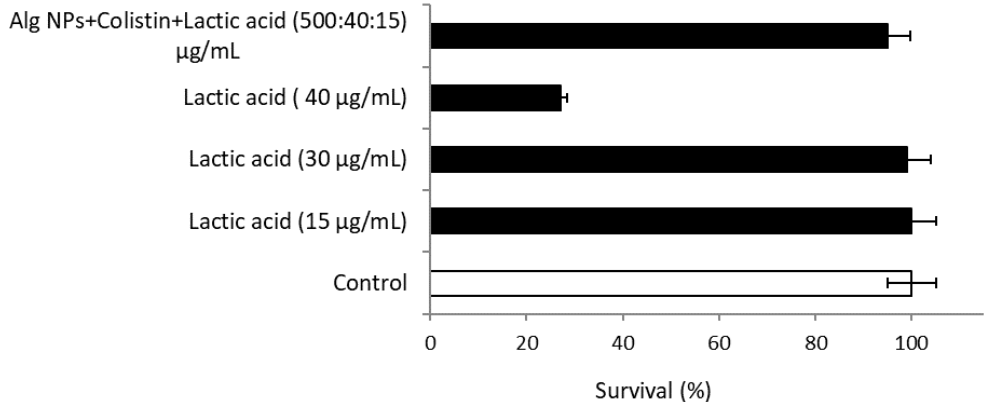
Figure 6. Cytotoxicity of lactic acid and Alg NPs+Colistin+Lactic acid formulation on HT-29 cells.